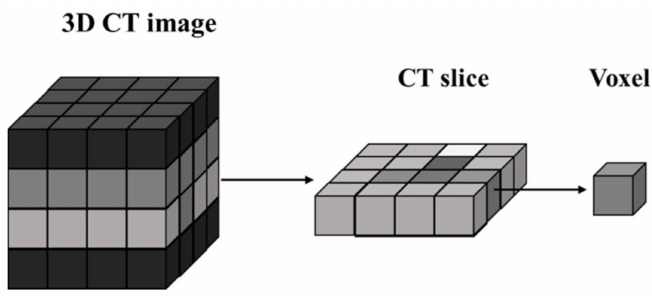
Figure 2. Construction of a 3D CT